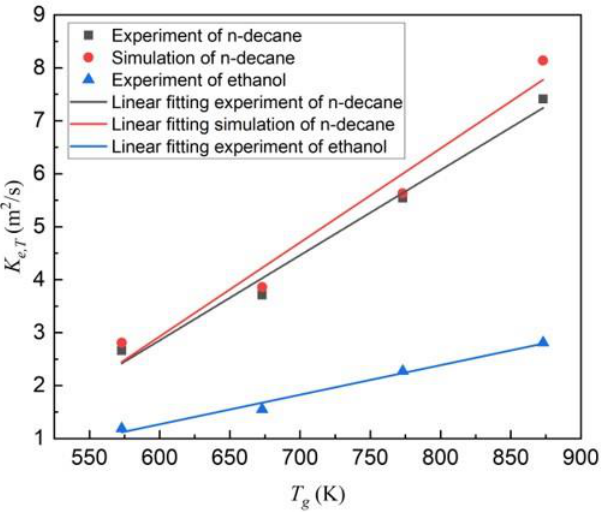
Figure 4. Experimental and numerical evaporation rate constants of mono-component n-decane droplets and experimental evaporation rate constants of mono-component ethanol at different ambient temperatures.